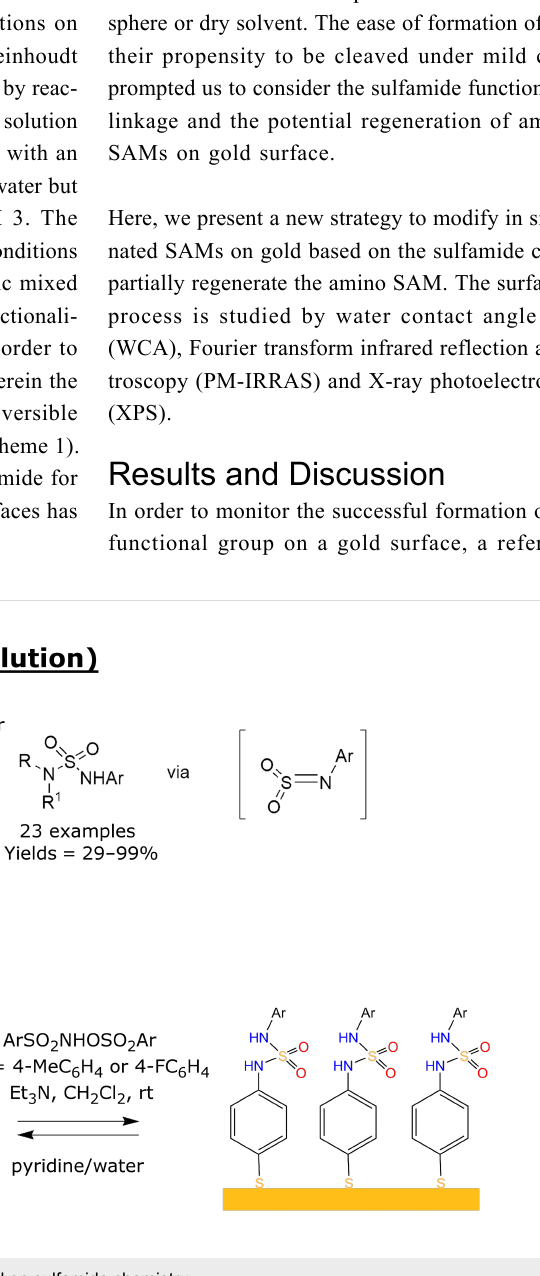
Scheme 1: General strategy for surface functionalization based on sulfamide